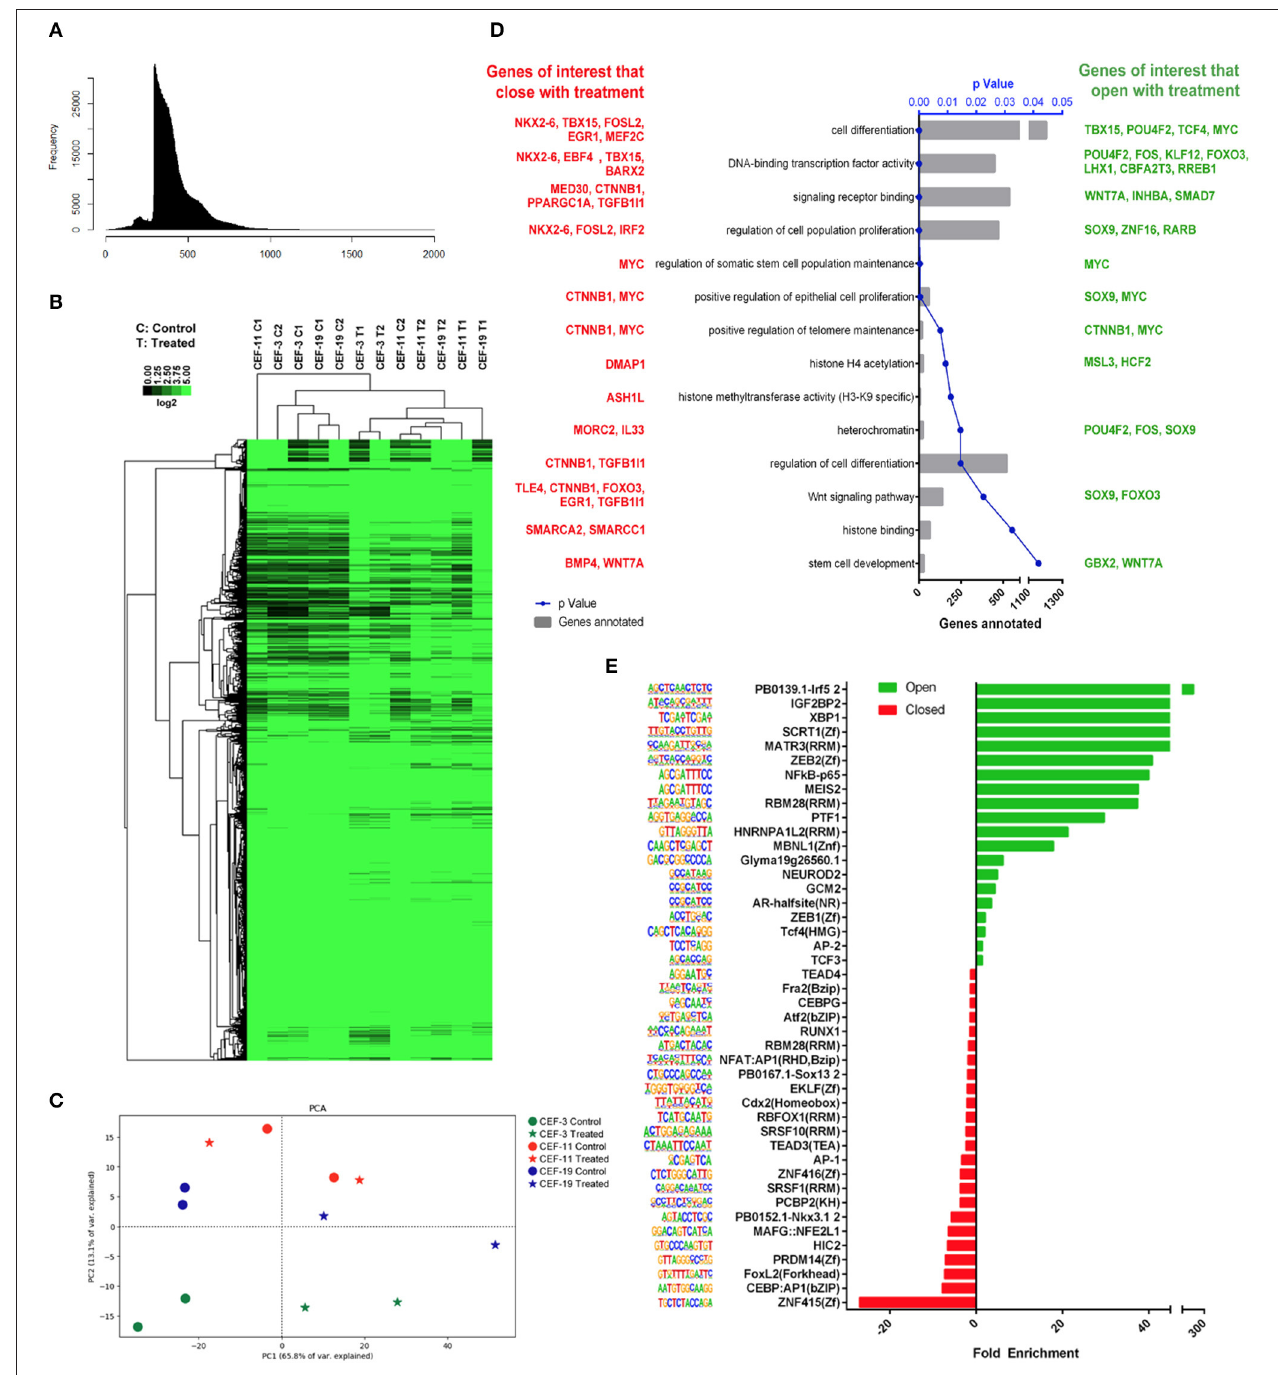
FIGURE 5 | Remodeling chromatin accessibility upon treatment of CEF with panobinostat and vitamin C. (A) Nucleosomal pattern of sequenced library. (B) Unsupervised hierarchical clustering and heatmap comparisons of ATAC-seq peaks from CEF vs . treated CEF. (C) Principal component analysis plot showing that direction of data changed (two replicates, three CEF cell lines) upon treatment. (D) GO terms of interest reclassification by PANTHER. Genes with adjusted p < 0.05 reclassified within “Pathway/TGF- β ,” “Pathway/Wnt,” “Pathway/PDGF,” and “MF/transcription regulator activity” GO classifications. Red: Genes of interest that became closed upon treatment. Green: Genes of interest that became more open upon treatment. (E) TF motifs enrichment upon treatment. CEF and canine iPSC compared with adult fibroblasts, suggesting binding motifs were closed by treatment, suggesting a decrease in that enhancing CBEP activity may promote canine somatic cell the functional capacity of this critical TF. Previous work from our reprogramming lab indicated that accessible CBEP binding motifs are enriched in